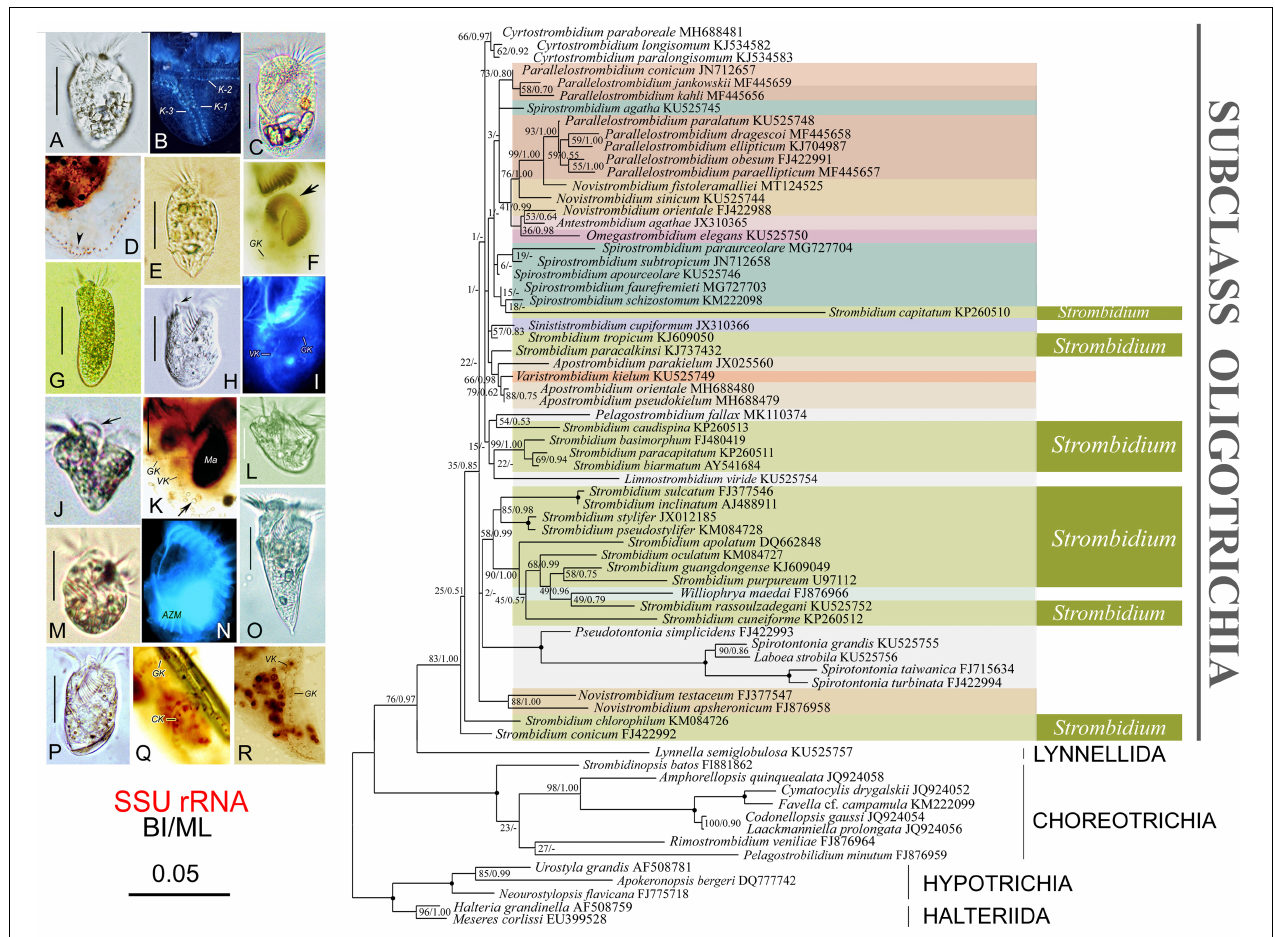
FIGURE 3 | Photomicrographs of specimens in vivo and after protargol staining of a representative species of each strombidiid genus (left) and maximum likelihood tree inferred from SSU rRNA gene sequence data (right). (A,B) Apostrombidium parakielum (after Song W. et al., 2013). (C,D) Spirostrombidium faurefremieti (after Wang et al., 2018). (E,F) Opisthostrombidium montagnesi (after Xu et al., 2006). (G) Varistrombidium kielum (after Xu et al., 2011). (H,I) Sinistrostrombidium cupiformum (after Liu et al., 2015b). (J,K) Strombidium paracapitatum (after Song et al., 2015b). (L) Novistrombidium (Novistrombidium) testaceum (after Song W. et al., 2013). (M,N) Williophyra maedai (after Liu et al., 2011). (O,R) Parallelostrombidium jankowskii (after Song et al., 2018). (P,Q) Antestrombidium agathae (after Liu et al., 2015b). Numbers at the nodes represent support values in the following order: BI posterior probabilities and ML bootstrap values. Disagreements in topology between the BI and ML trees are indicated by a hyphen. Nodes that were maximally supported (1.00 BI; 100% ML) are represented by filled circles. Scale bar, three substitutions per 100 nucleotide positions. Species discussed in the present study are shown in bold